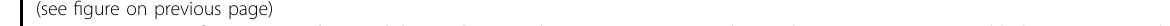
Fig. 1 Generation of GCK-PNDM dogs with base editing. a The target sequences at the GCK locus. Target sequences (black), protospacer adjacent motif (PAM) region (blue), target sites (green). b Sequence motif of livers from the GCK-PNDM dogs (190619, 190627, and 190761) and the ear punch tissue from the chimeric dog (190628). c , d Blood glucose levels of WT ( n = 2) and the GCK-PNDM dogs ( n = 4, 190619, 190627, 190628, and 190761) from the 1st day to the 11th day after birth ( c ) and from the 1st week to the 27th week ( d ). e – g Body weights of WT ( n = 2) and the GCK-PNDM dogs ( n = 4, 190619, 190627, 190628, and 190761) from the 1st day of birth to the 11th day after birth ( e ) and from the 1st week to the 27th week ( g ). Photographs of WT dog (left) and the insulin untreated GCK-PNDM dog (right: 190619) at the 5th day after birth ( f ). h , i Histological analysis of WT (10 d and 190 d), GCK -/- + insulin (190 d), and GCK -/- – insulin (7 and 11 d) dogs. H&E staining of kidney sections (top) showed the amount of mesangial matrix and the thickness of the glomerular basement membrane (white arrow). PAS staining of liver sections for analysis of glycogen (purple color) synthesis ( h ). Oil red O staining of liver sections (top) for analysis of lipid droplets (red color) accumulation. Masson ’ s trichrome staining (blue color) of heart sections for analysis of myocardial fi brosis in myocardium ( i ). Scale bar: 80 μ m. j Hierarchical clustering analysis of liver cells from WT and insulin treated GCK-PNDM dogs. Red and blue represent higher and lower gene expression levels, respectively. Data represented three biological replicates. k Gene ontology enrichment analysis of the genes differentially expressed in biological processes between the insulin-treated GCK-PNDM and WT dogs. P < 0.05. l Bar plots of representative genes involved in the glycolytic pathway. *** P < 0.001; ns, not signi fi